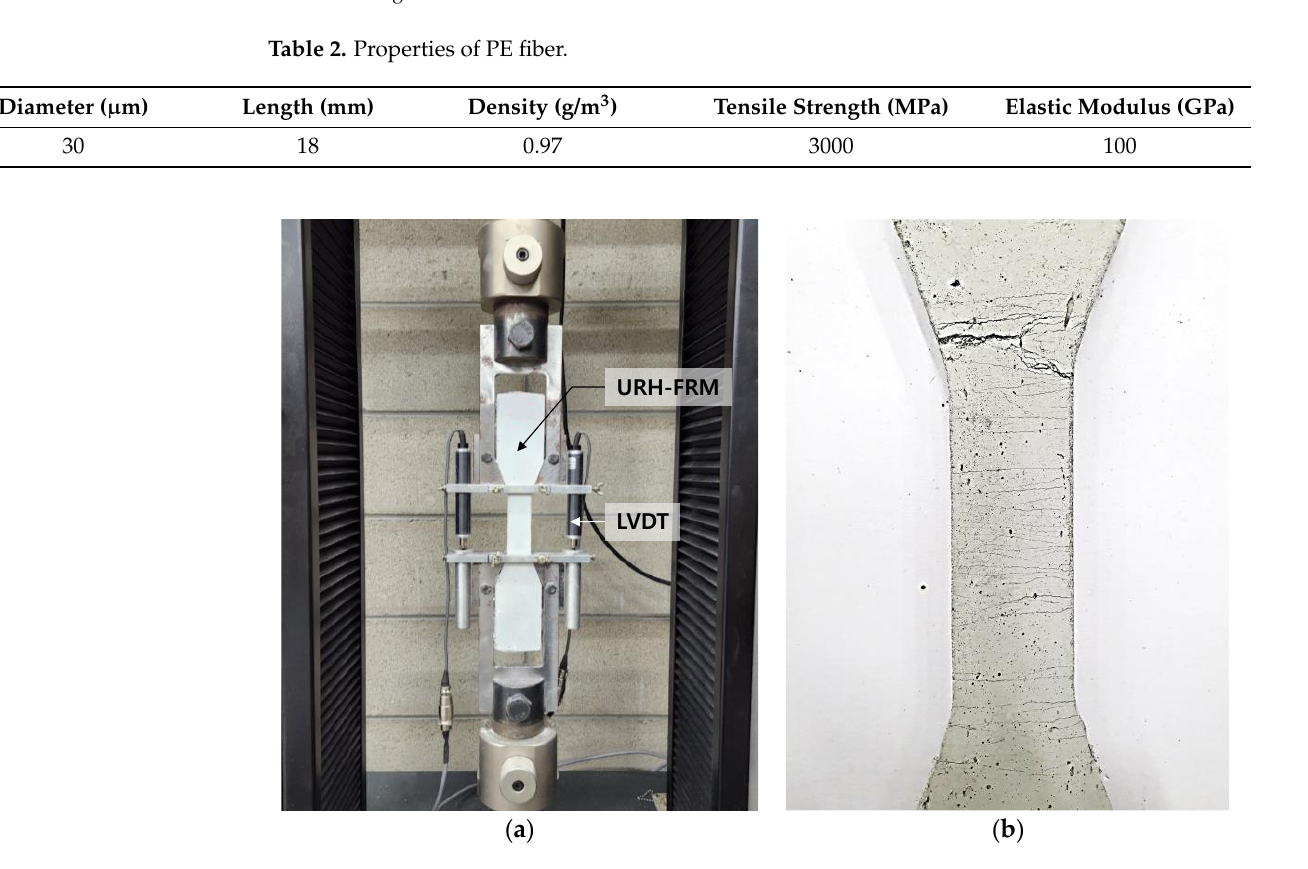
Figure 1. Direct tensile test of I-shaped URH-FRM: ( a ) Test setup; ( b ) URH-FRM specimen after testing.